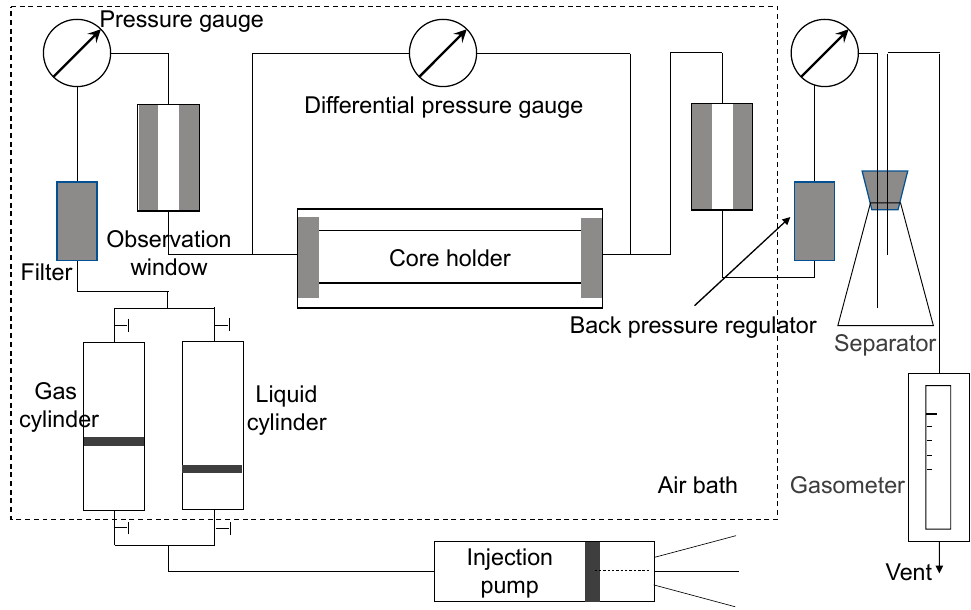
Figure 2. Schematic diagram of the core displacement device.